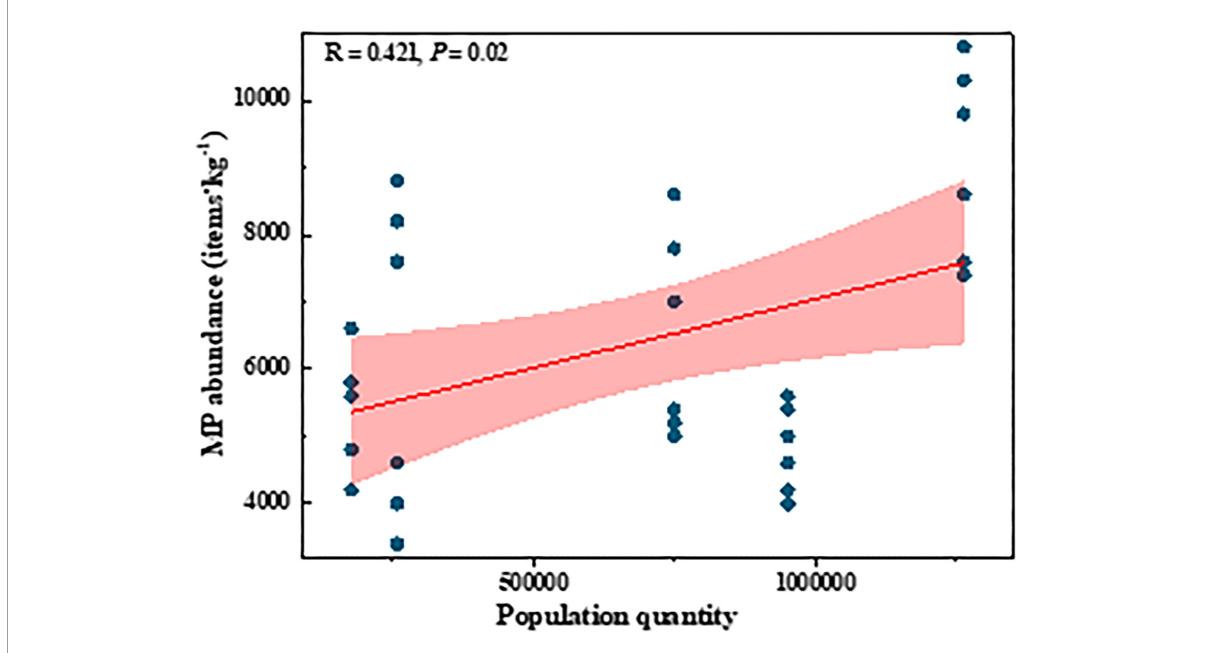
FIGURE7 Linear correlations between MP abundance and population quantity.